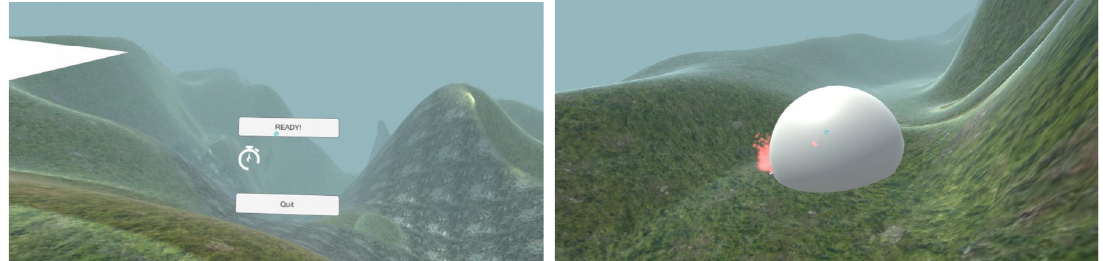
Figure 7. The example of simulated glider flight trajectory is presented in Figure 8.